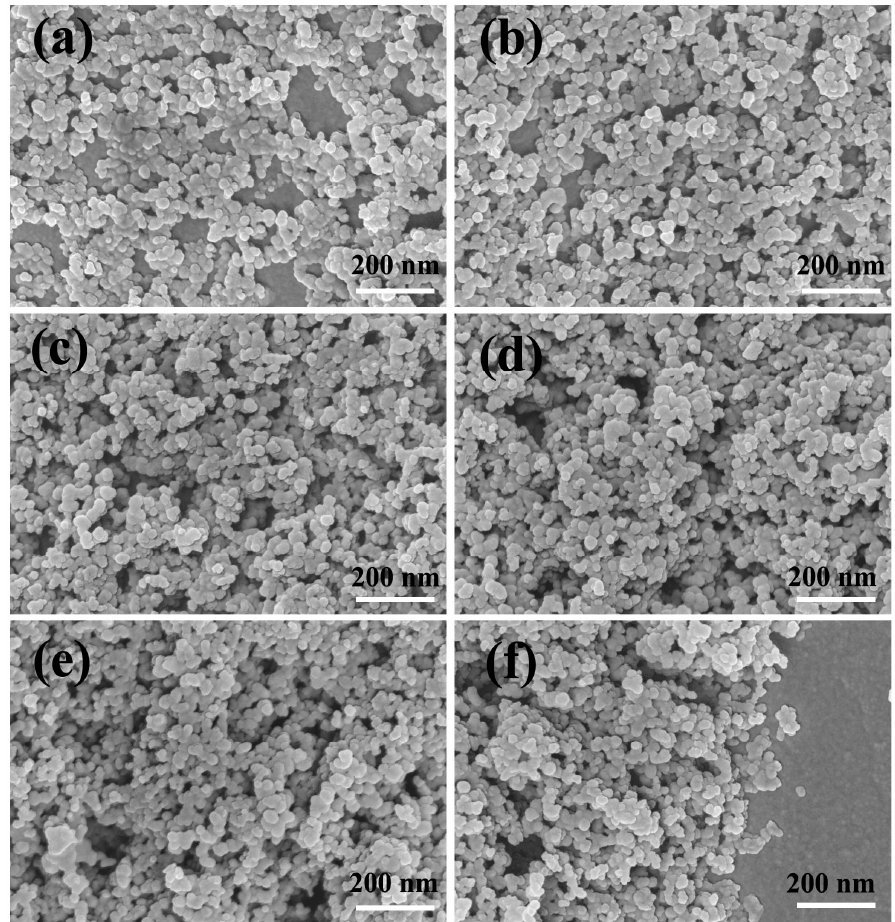
Figure 7. SEM images of CS films: ( a ) the first-layer CS film; ( b ) the second-layer CS film; ( c ) the third-layer CS film; ( d ) the fourth-layer CS film; ( e ) the fifth-layer CS film; ( f ) the lateral SEM image of the fifth-layer CS film.